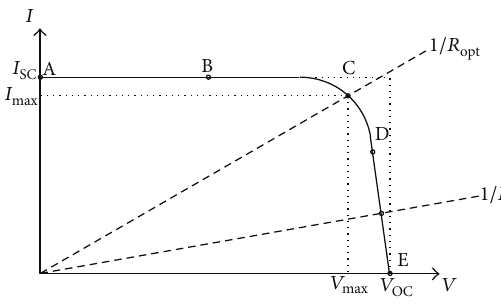
Figure 3: Specific 𝐼 - 𝑉 characteristics of solar